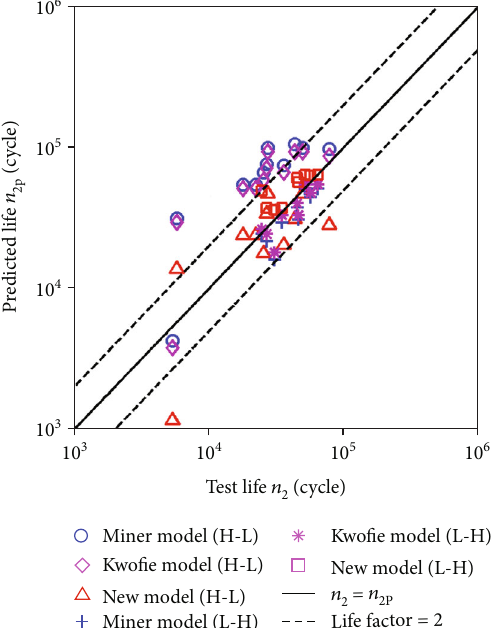
Figure 8: Comparison of theoretically predicted and experimentally obtained remaining lives of the 30NiCrMoV12 alloy steel.